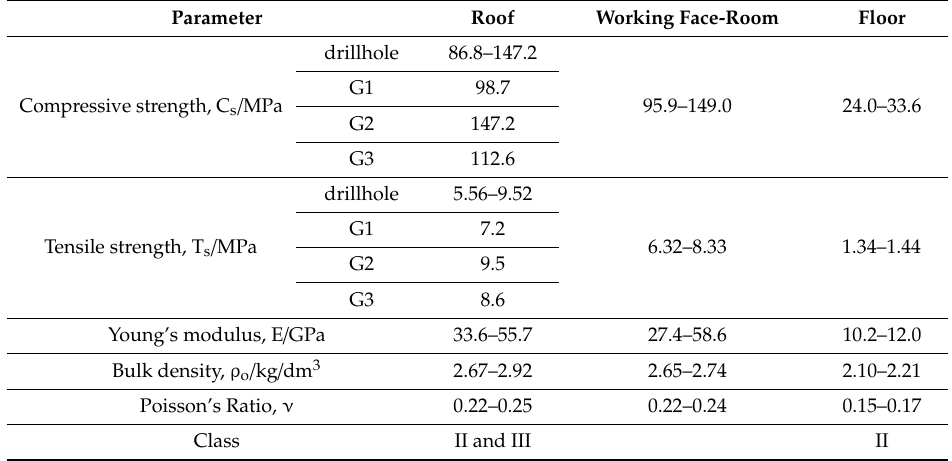
Table 5. Geomechanical properties of rocks in the exploitation field B.